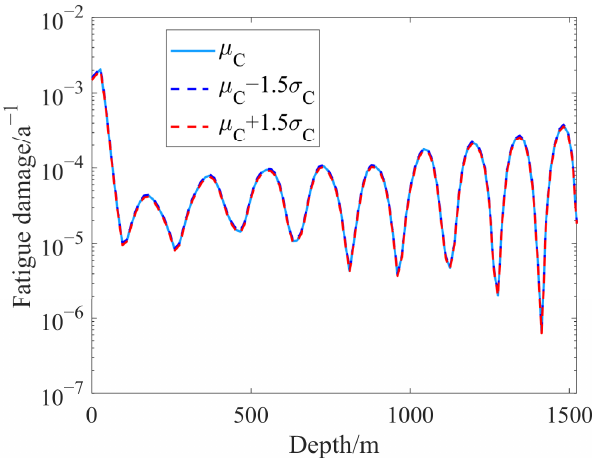
Figure 10. Effect of C on fatigue damage.